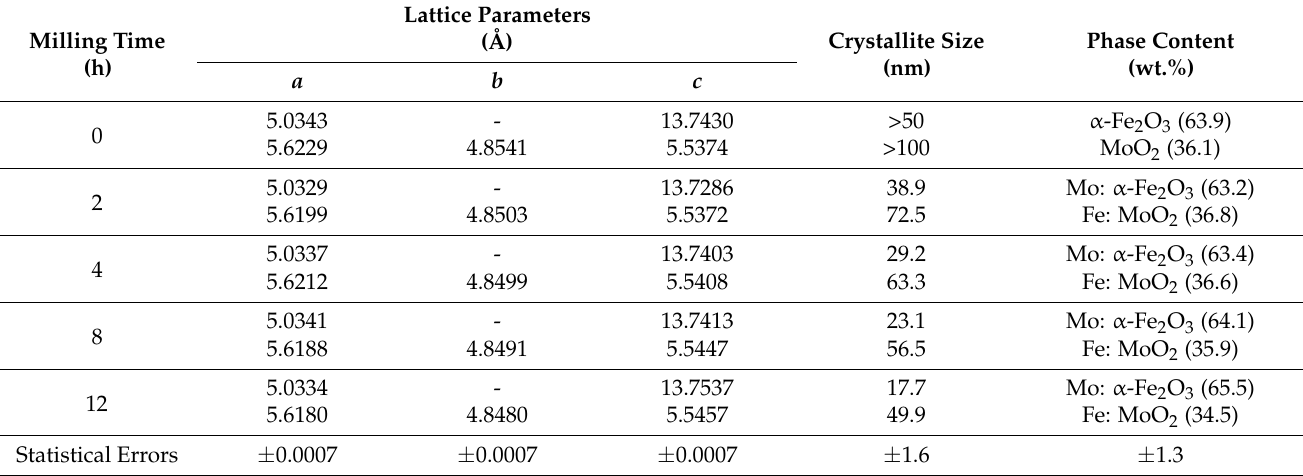
Table 1. The lattice parameters, crystallite size, and phase content from XRD patterns by Rietveld refinement and the Scherrer method for mechano-chemically activated MoO 2 -Fe 2 O 3 nanocomposites at ball-milling times of: 0, 2, 4, 8, and 12 h, respectively.